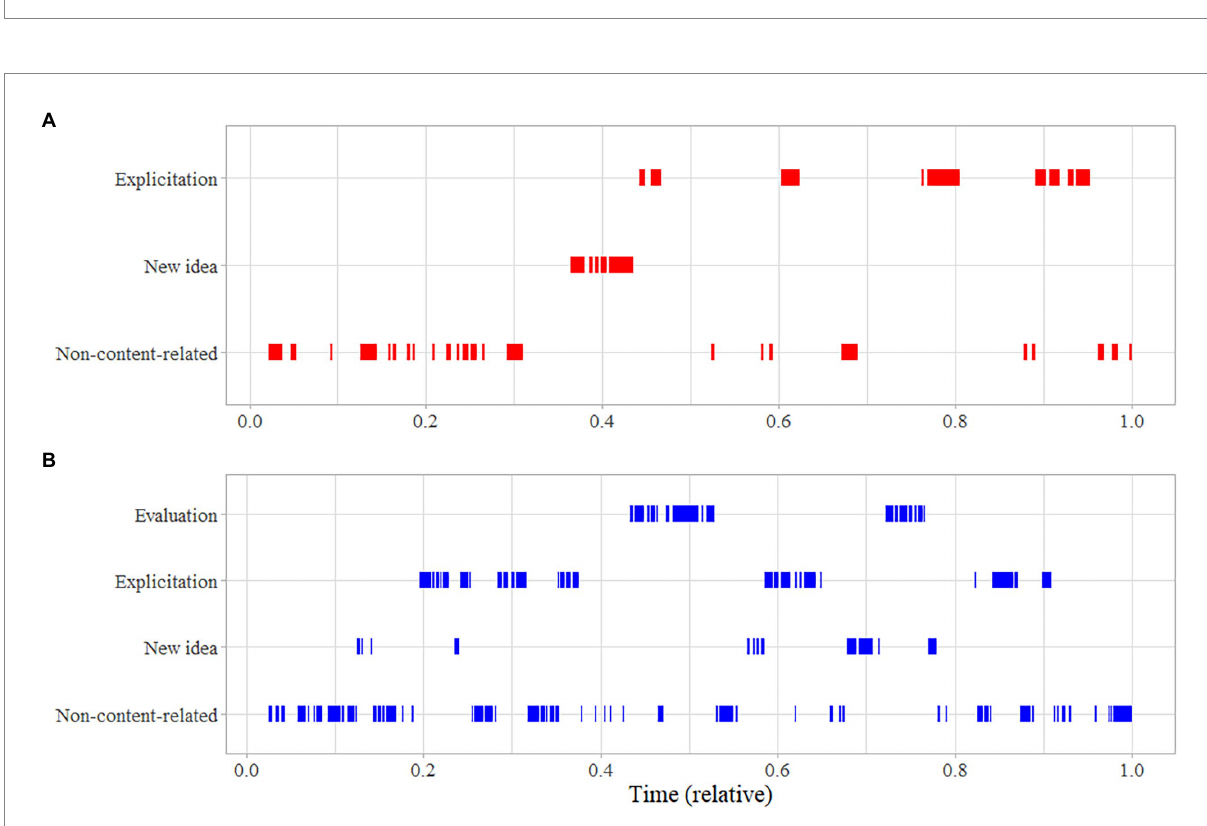
FIGURE 5 Visualization of the collaborative knowledge construction (CKC) process of (A) pair 1 and (B) pair 2. The duration of the CKC process was 5.3 min for pair 1 and 12.8 min for pair 2.